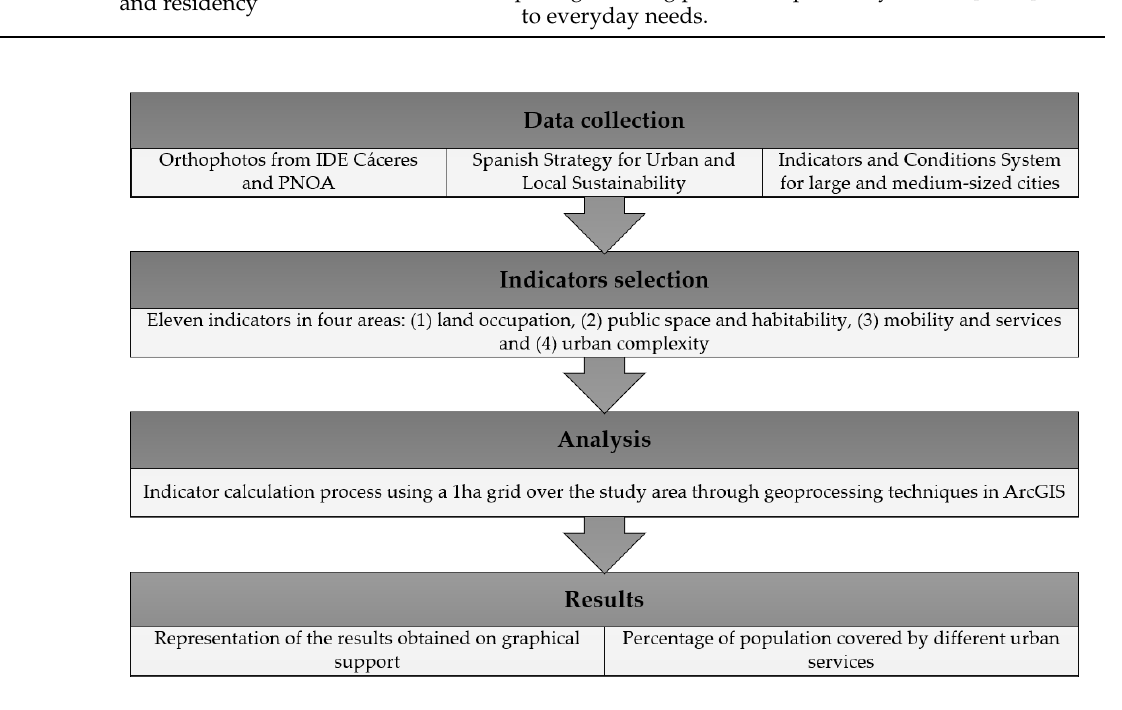
Figure 2. Flow chart of the applied methodology.